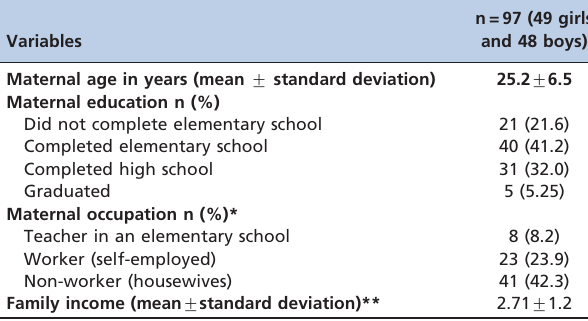
Table 1 - Socioeconomic characteristics of the sample.